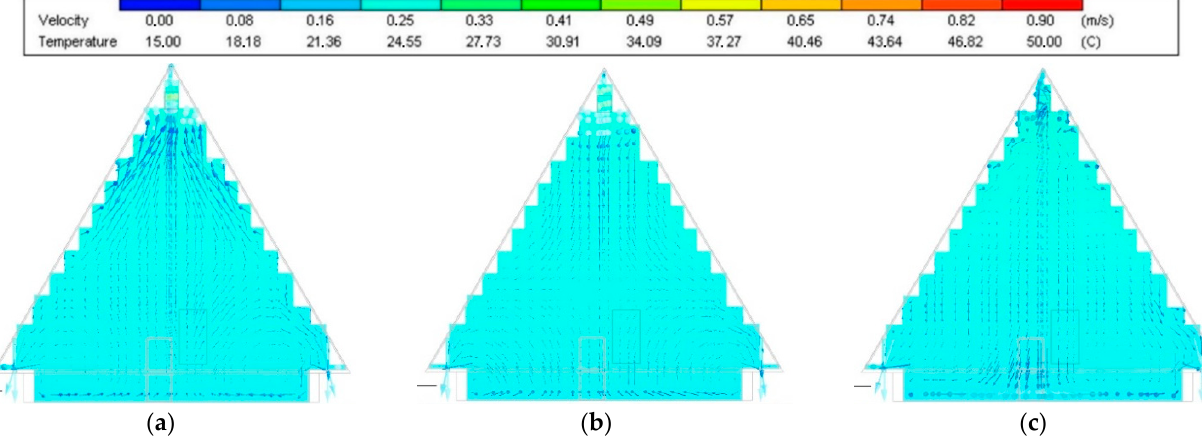
Figure 14. Simulated airflow paths on 6.6. at 6:00 p.m. in cross section: ( a ) 0.8 m from the sanctuary wall; ( b ) in the middle of attic space; ( c ) 0.8 m from the wall of the tower.